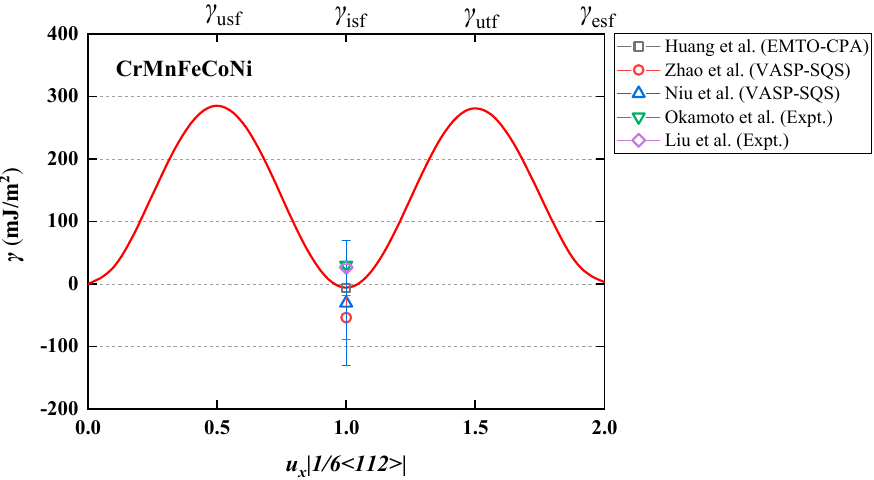
Figure 2. Theoretical generalized stacking fault energy ( γ , in mJ / m 2 ) of paramagnetic (PM) fcc CrMnFeCoNi alloy calculated at room temperature. The theoretical (exact muffin-tin orbitals-coherent-potential approximation (EMTO-CPA), Vienna ab initio simulation package-special quasi-random structure (VASP-SQS)) [18,33,34] and experimental (Expt.) [9,15] γ isf are plotted for comparison.